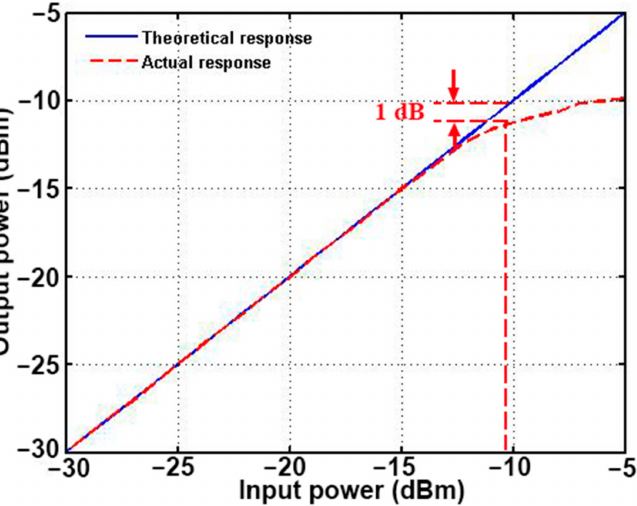
Figure 18. The measured P1dB of the NBPF at V BP2 with the input power when f o was 165.8 kHz.